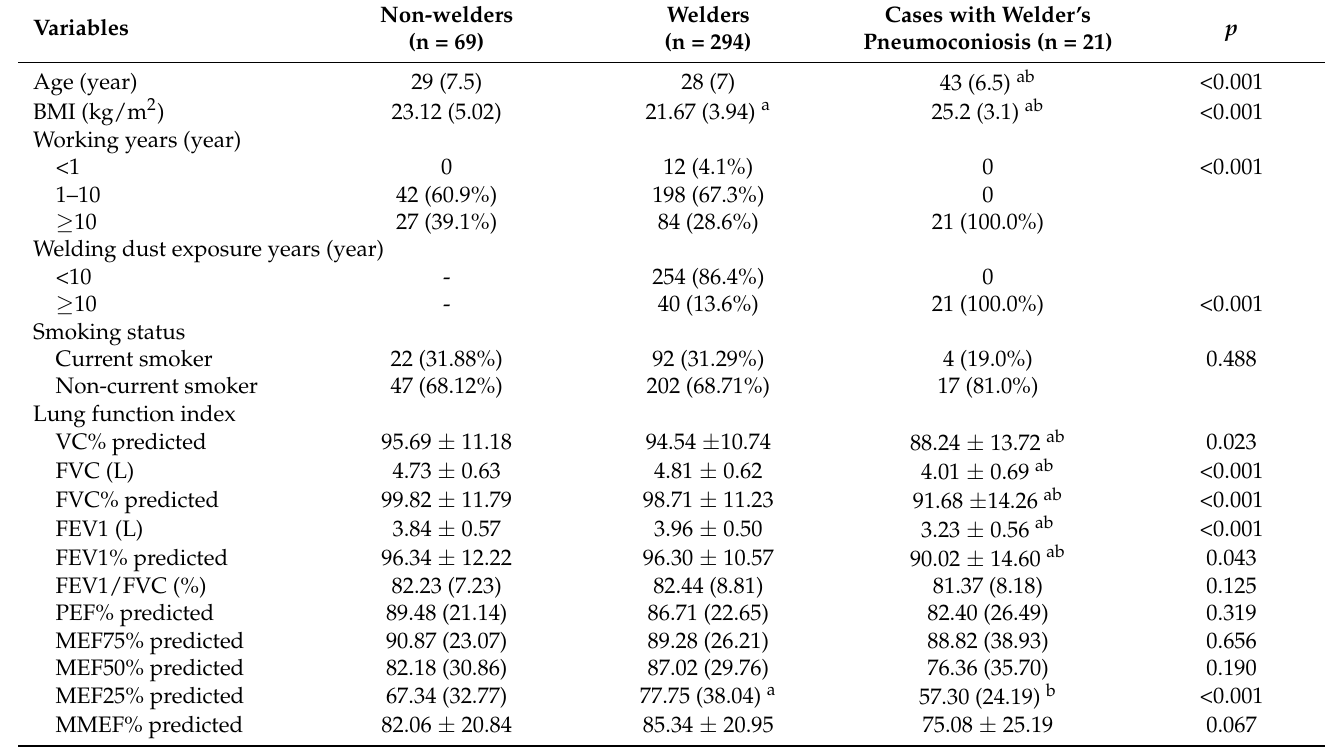
Table 1. Demographic characteristics and lung function parameters of